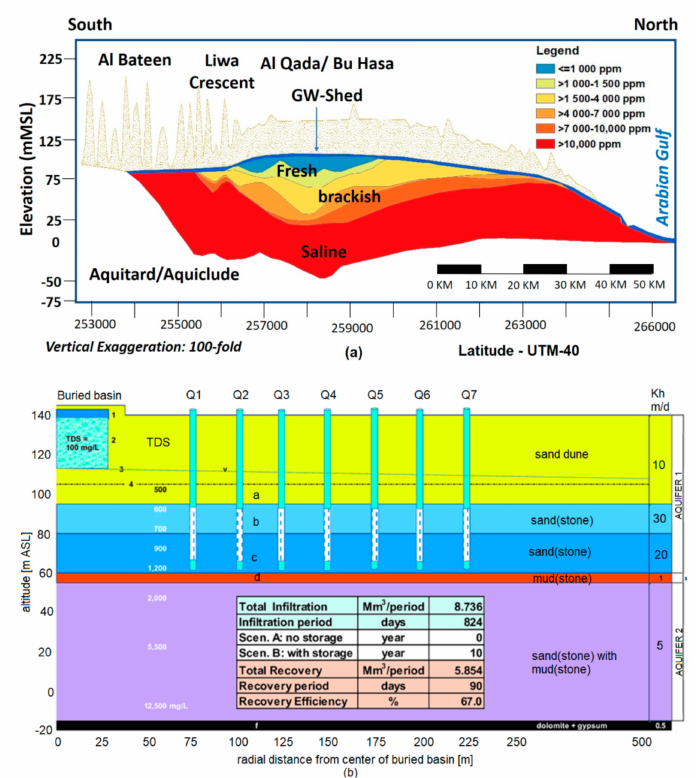
Figure 2. ( a ) A schematic description of the Liwa aquifer and ( b ) a well cross-section.